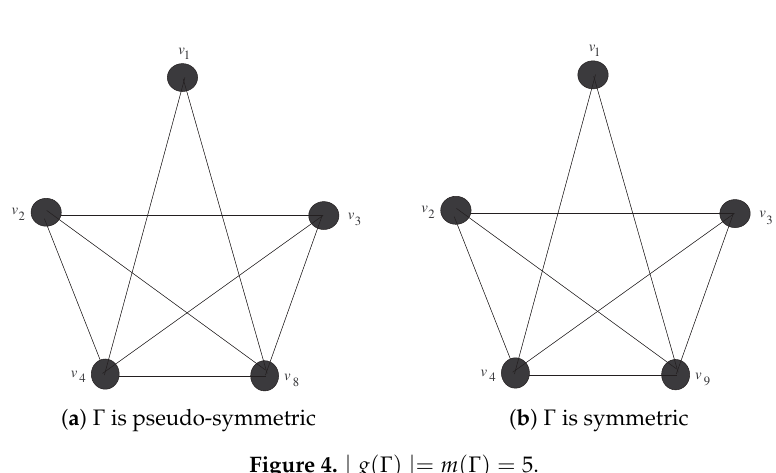
( b ) Γ is symmetric